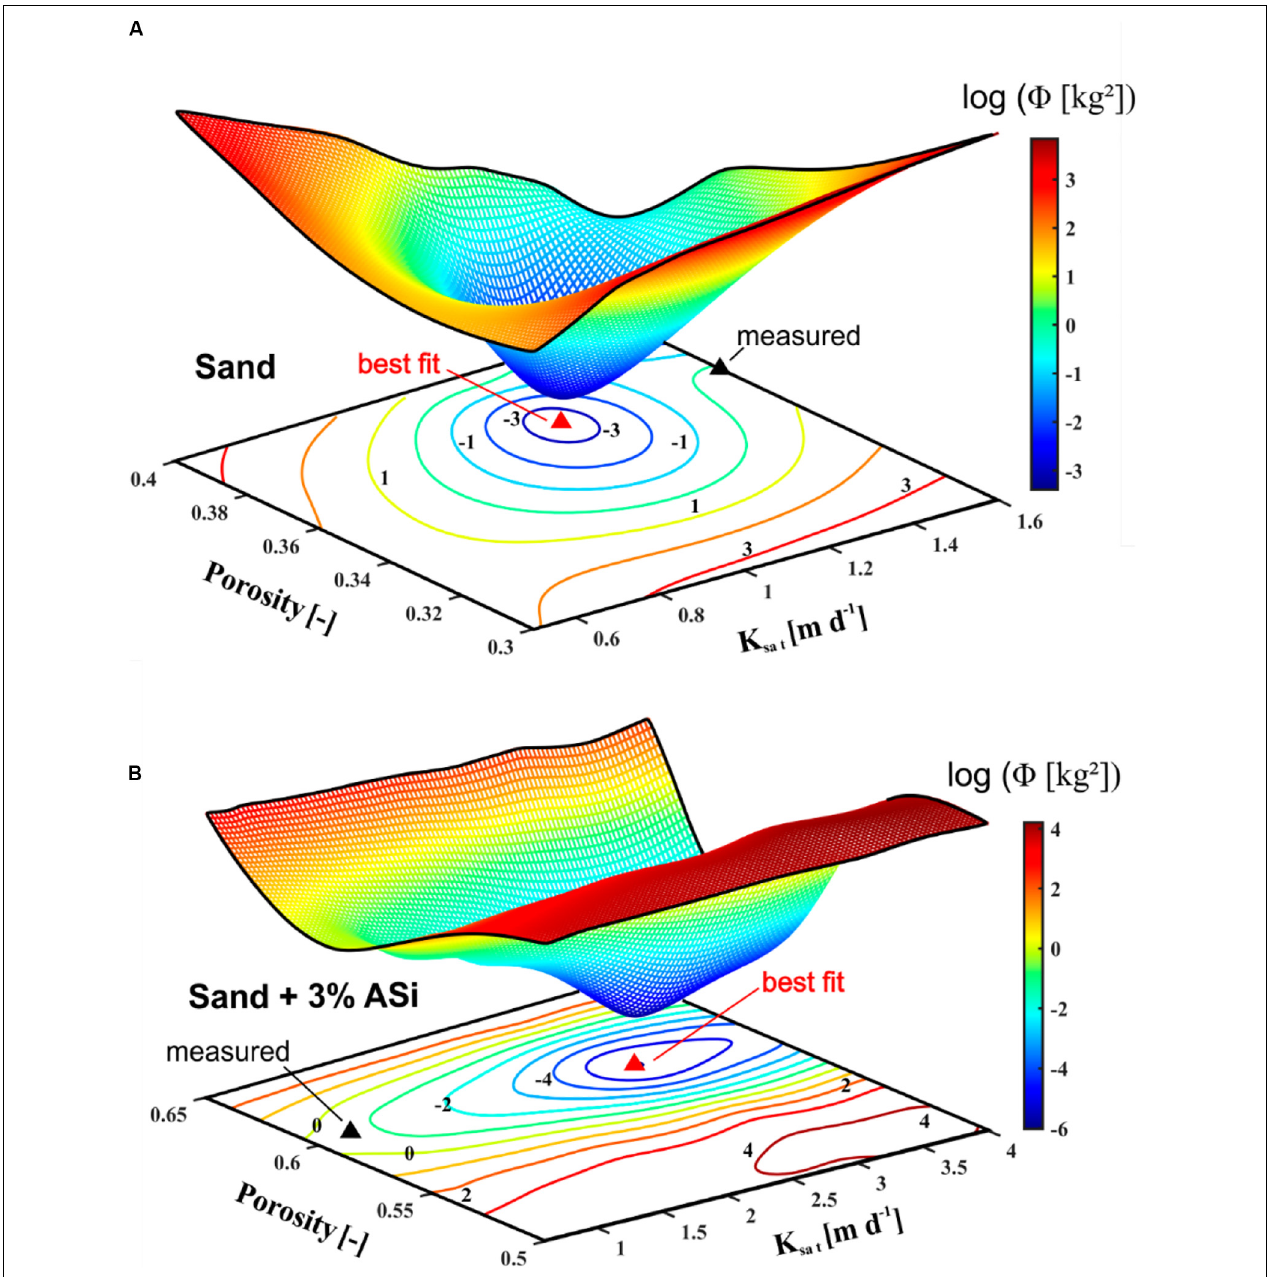
FIGURE 9 | Objective function for the simulations representing the pure sand (A) and sand containing in 3% ASi (B) defined in the K sat /porosity parameter space. Measured parameter sets are indicated by black triangles and best fit sets, minimizing the objective functions, by red